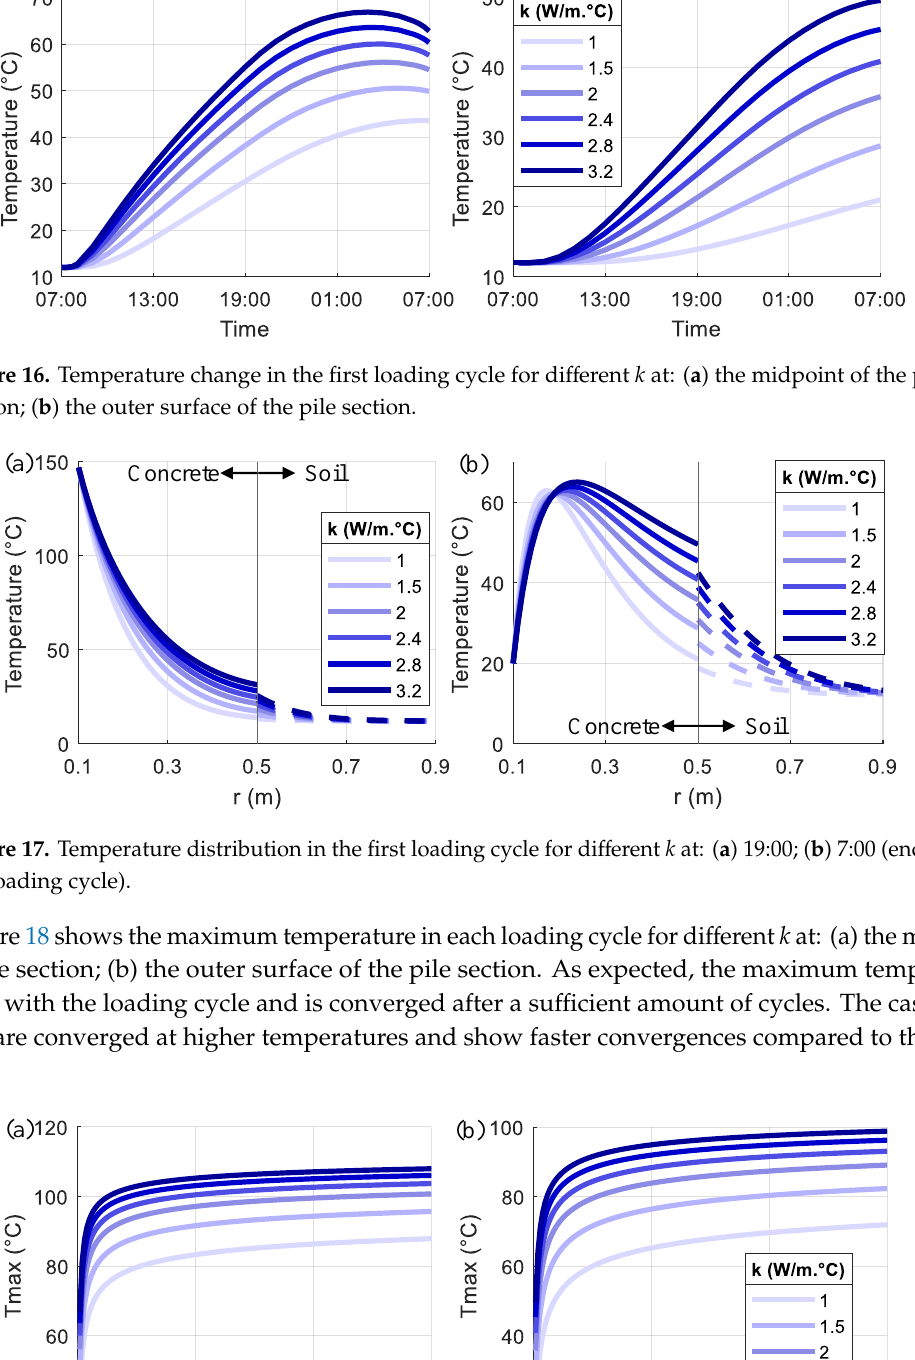
Figure 19. Temperature change in the first loading cycle for different c at: ( a ) the midpoint of the pile section; ( b ) the outer surface of the pile section. To quantify the effect of d i , k, and c on the heat transfer response in the concrete pile foundation, a variable, C conv , is defined as the number of cycles, which is required to have the temperature in the concrete section converged at a stable value. This stable value is quantified as the variation of the maximum temperature at the outer surface of the pile foundation between adjacent cycles to be less than 0.05 °C. Figure 20 shows the calculated C conv for all cases studied in this paper. As seen in Figure 20, the required convergence cycle reduces as the d i increases and the section thickness reduces, which requires less time for the heat transfer. As for the effect of concrete thermal properties, when k increases and c decreases, the heat transfer speed increases, which requires fewer cycles for the convergence. The influence of c is much smaller than d i and k , which can be omitted.